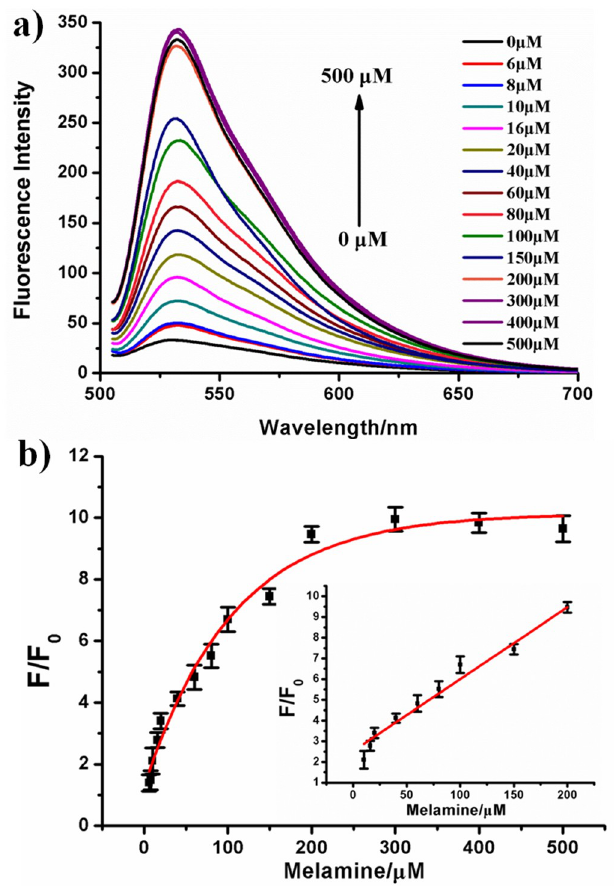
Figure 3. ( a ) The fluorescence emission spectra in the presence of difference melamine concentrations. ( b ) The fluorescence intensity signal change F/F 0 for melamine concentrations ranging from 6 to 500 µ M, which matched the dose-response curve. Inset: the signal change matched a linear relationship at concentrations of 10–200 µ M. F 0 and F are the area under curve of the emission spectra in the absence and presence of melamine, respectively. Error bars were estimated from at least three independent